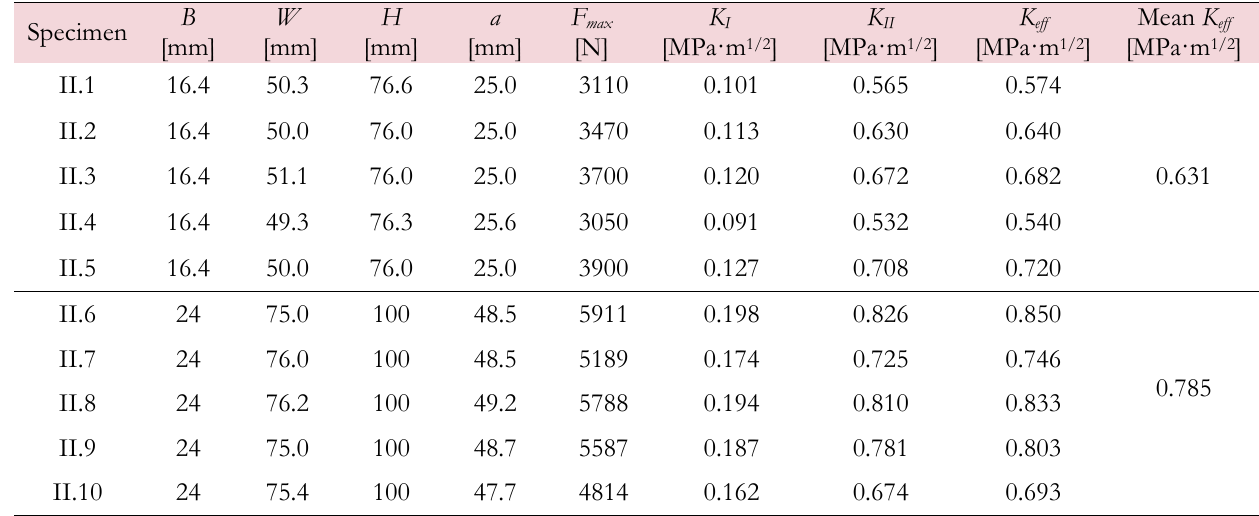
Table 2: Mode II fracture toughness